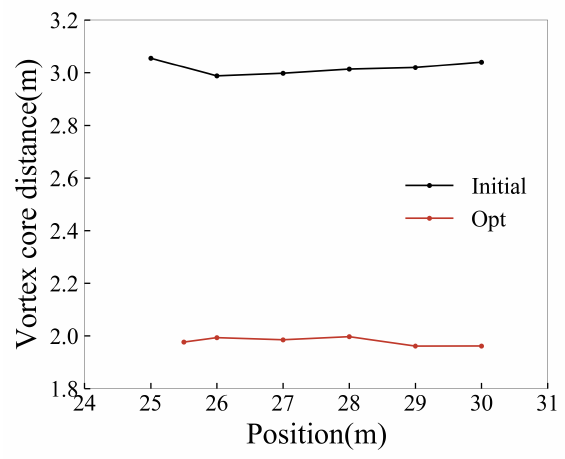
Figure 23. Vortex footprint of the military aircraft.